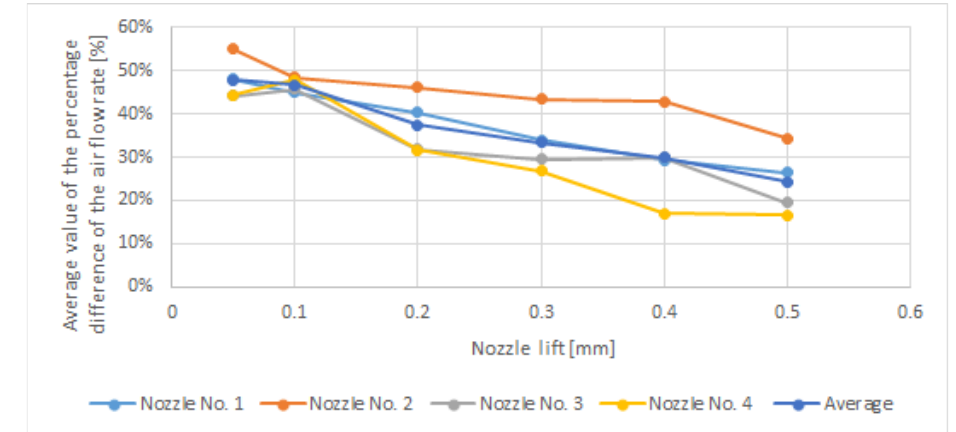
Figure 13. The mean value of the airflow rate for SD3.